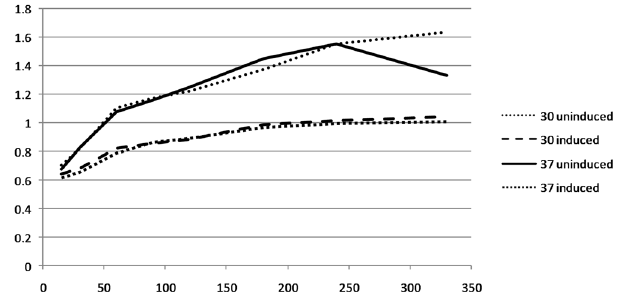
Figure 2. The graph has been plotted for O.D 600 (Y-axis) and different time points (X-axis) of transformed NEB express cells grown with and without 0.3 mM IPTG at 30 °C and 37 °C. Solid straight line and round dotted line represents the growth of transformed cells without induction at 37 °C and 30 °C respectively. Broken solid black line (30 °C) and solid squares (37 °C) represents the growth pattern of transformed cells after